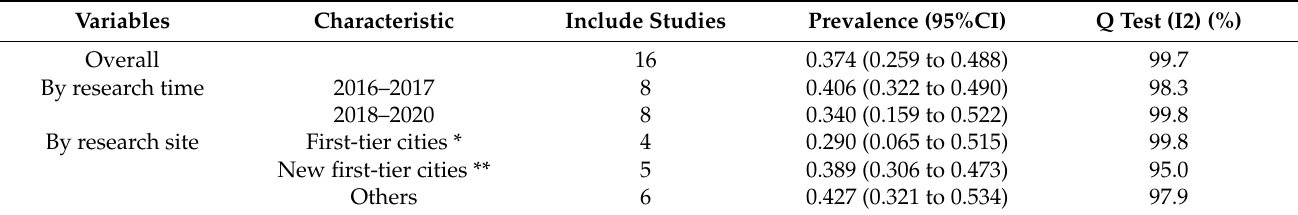
Table 2. Prevalence of SFI among urban women in